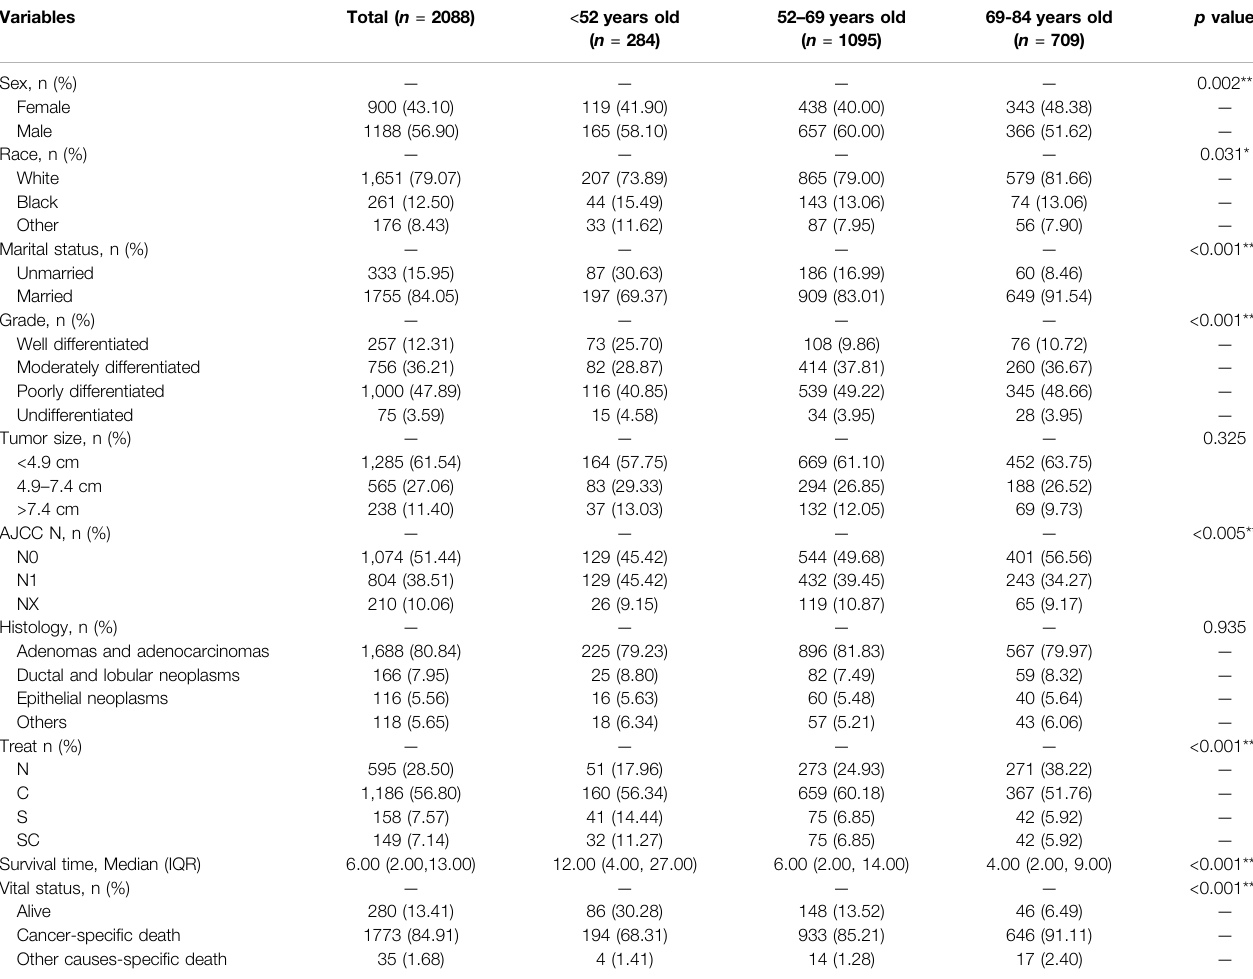
TABLE 2 | Clinical characteristics of the patients with pancreatic cancer metastasis to liver grouped by age at diagnosis.